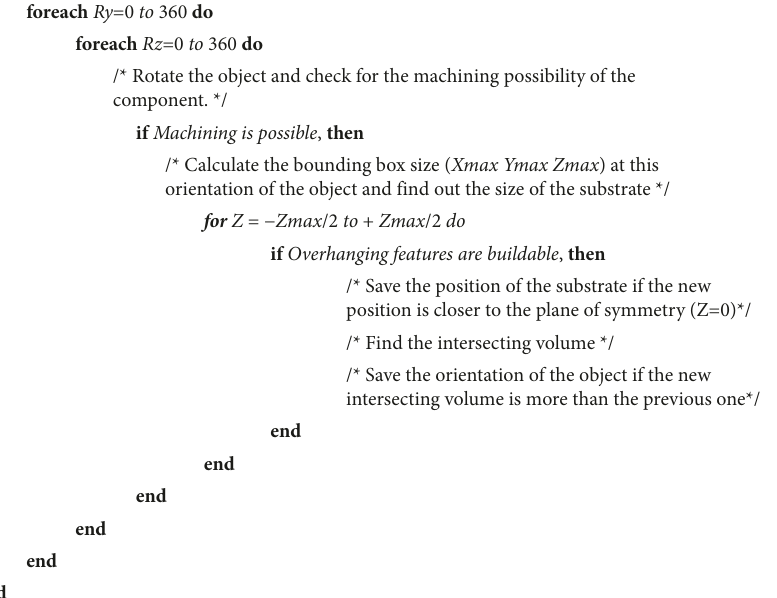
Figure 3: Algorithm 1 for calculation of the optimal position of the embedded substrate.